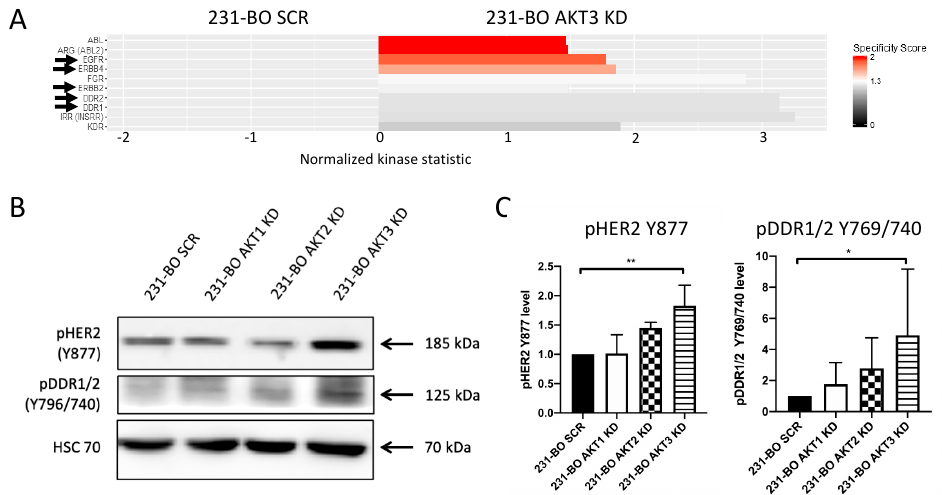
Figure 8. Knockdown of AKT3 in 231-BO cells increases activity and phosphorylation of HER2 and DDR1/2: ( A ) To identify alterations in tyrosine kinase activity in the AKT3 knockdown of 231-BO cells, we performed functional kinome profiling of whole cell lysates. The resulting upstream kinase analysis of 231-BO SCR versus 231-BO AKT3 KD is depicted (normalized kinase statistic (log2) > 0: higher kinase activity in KD; specificity score (log2) > 1.3; white to red bars: statistically significant changes). Arrows indicate kinases that are discussed in the following. ( B ) Western blot analysis was conducted as a proof of principle for some identified upregulated kinases from kinome profiling. Antibodies directed against the indicated proteins were used. HSC70 functions as a loading control. ( C ) Relative levels of pHER2 Y877 and pDDR1/2 Y769/740 in 231-BO AKT isoform knockdowns compared to 231-BO SCR cells were quantified from Western blot analysis of triplicates. Data were normalized to Ponceau staining. Bars indicate mean with SD; * = p < 0.05; ** = p < 0.01.